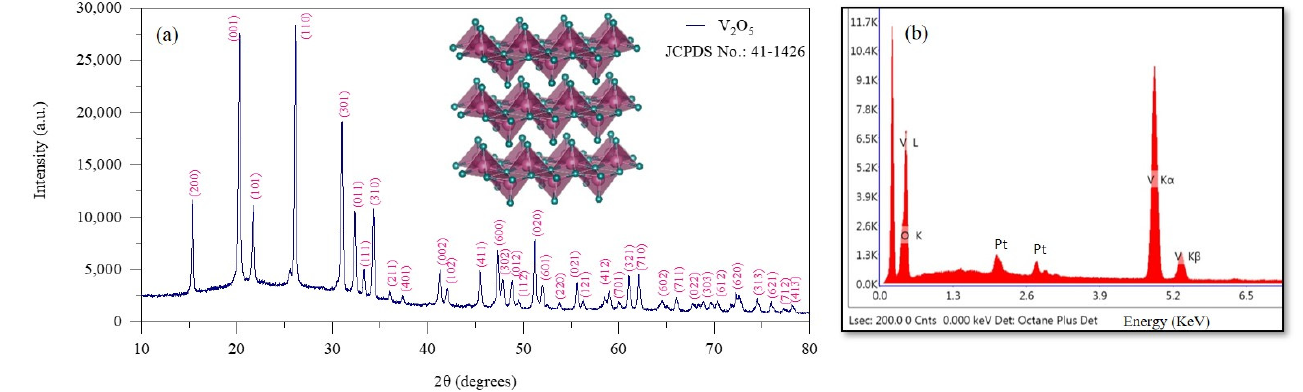
Figure 2. ( a ) Powder XRD patterns and ( b ) EDS spectra of the as-prepared V 2 O 5 sample with the layered crystal structure.